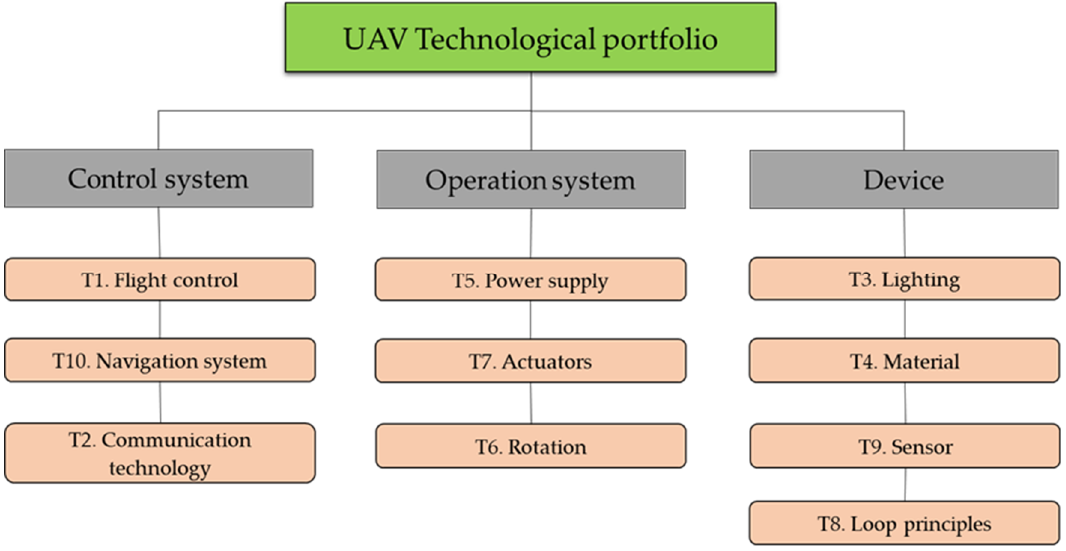
Figure 6. Technological portfolio of UAV.